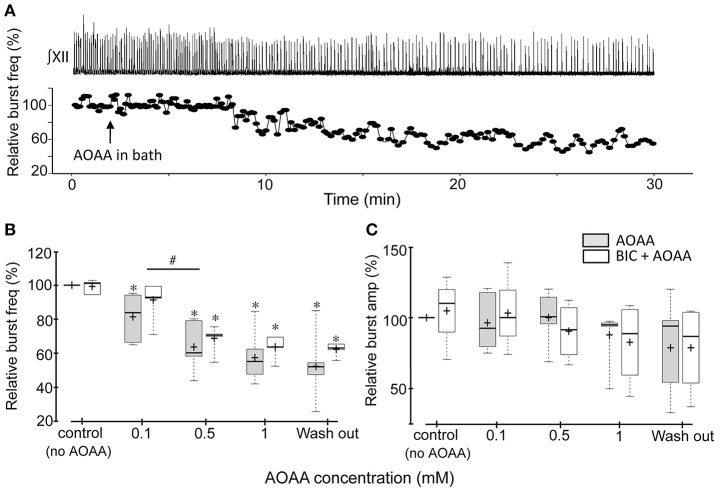
Effects of AOAA on rhythmic inspiratory-related activity recorded from the XII nerve root of medullary slice preparations. (A) Representative medullary slice preparation showing the time course of how instantaneous frequency, calculated from the recordings shown (∫XII nerve, top trace), changes following bath application of 1 mM AOAA (indicated by the black arrow). The time scale of the nerve recordings and instantaneous frequency plots are matched. (B,C) Box plots of group data showing the dose-dependent effects of bath-applied AOAA on the XII inspiratory burst frequency (B) and amplitude (C) of AOAA bath-applied alone (n = 7), and, in a different group of slice preparations, in combination with bicuculline (3 μM, n = 7). The effect of bicuculline alone is presented in the control group data set. *indicates significant difference (p < 0.05) compared to control (baseline), #indicates significant difference (p < 0.05) between the indicated doses.